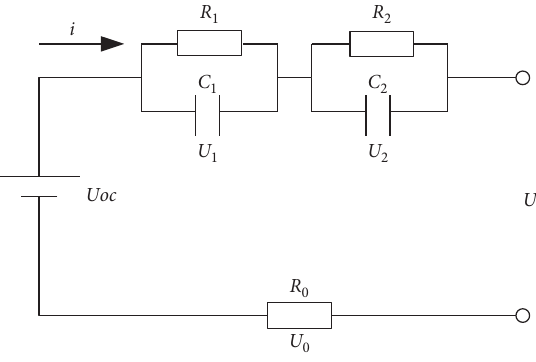
Figure 1: Thevenin second-order RC equivalent